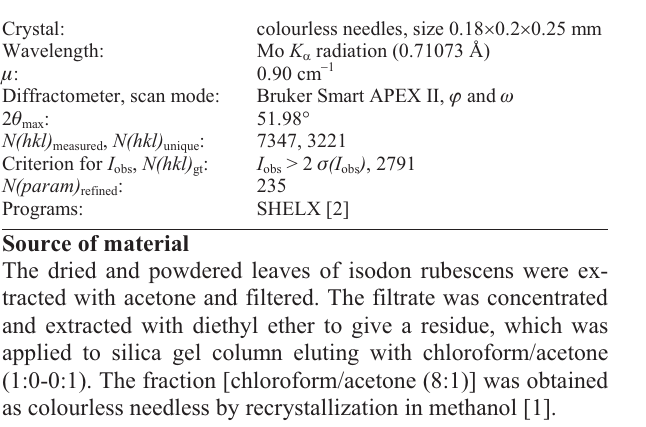
Table 1. Data collection and handling.